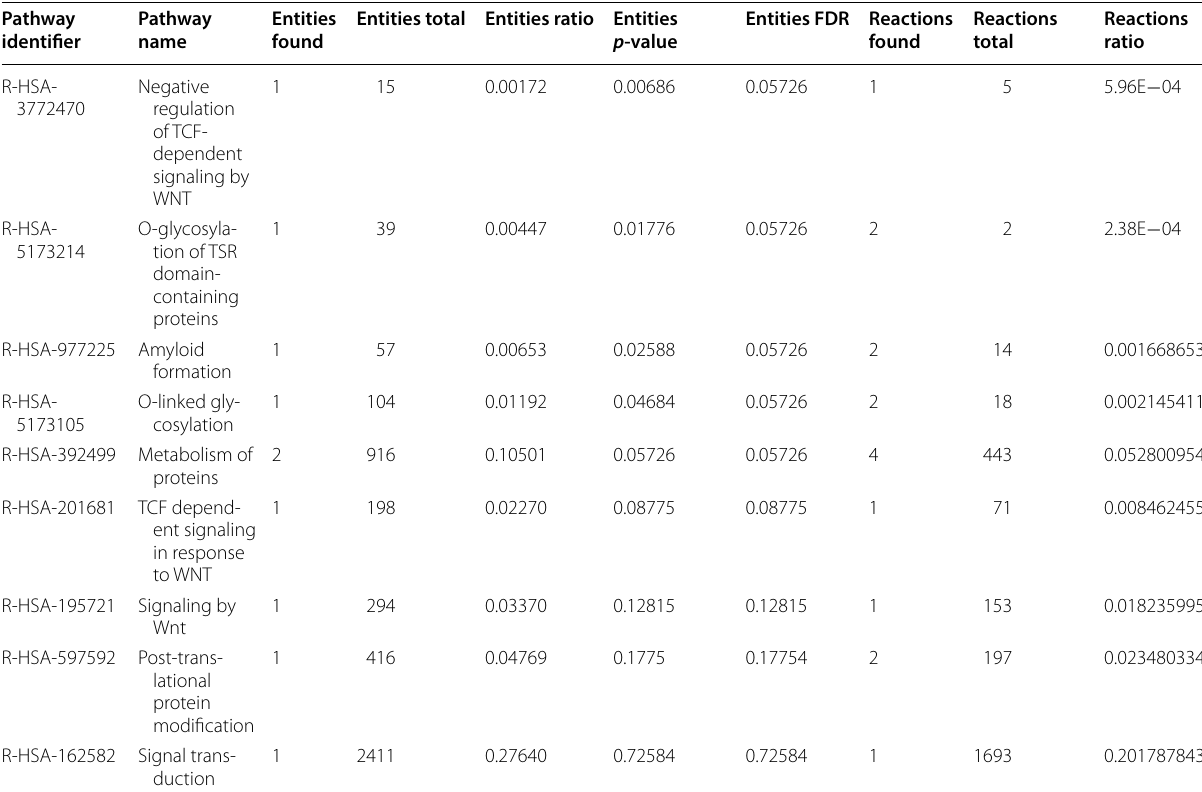
Table 2 Pathway enrichment analysis of potential biomarkers using Enrich tool Pathway